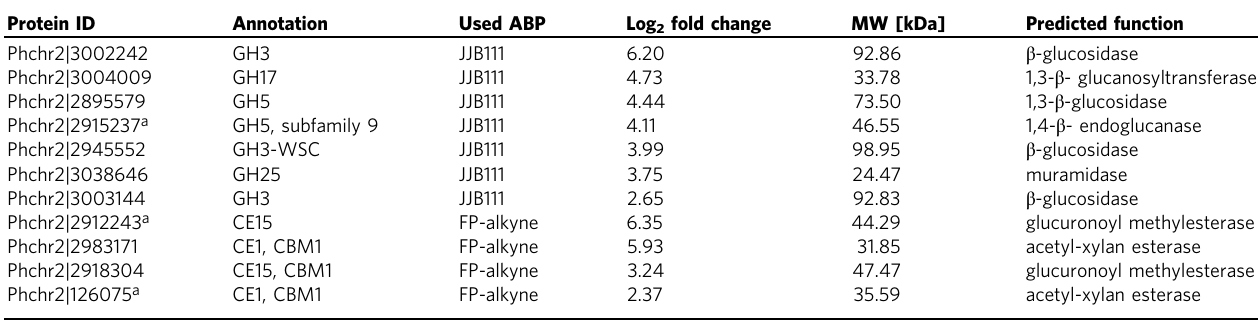
Table 2 Overview of the ABPP-identi fi ed enzymes from pro fi ling the substrate-bound fraction (SBF) of P . chrysosporium suspension cultures grown on minimal medium supplemented with beech wood chips. Protein